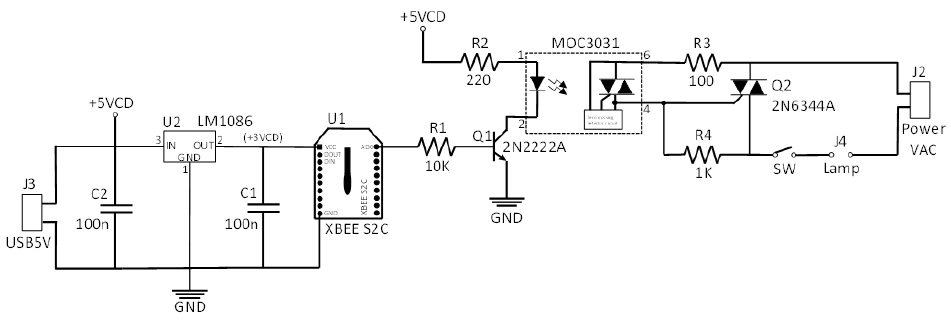
Figure 4. Actuator, solid-state switch.